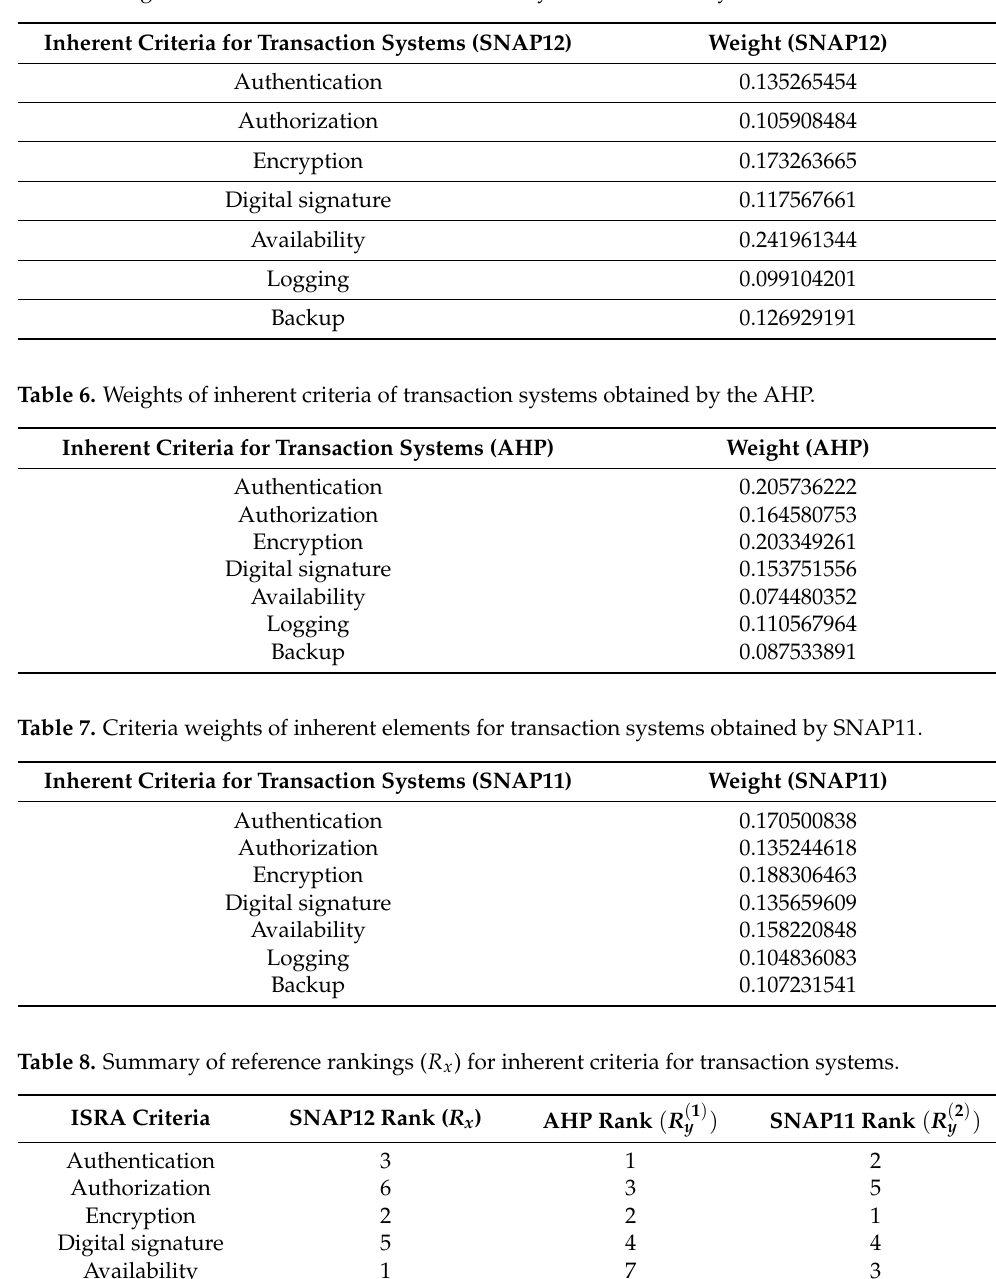
Table 5. Weights of inherent criteria for transaction systems obtained by SNAP12.